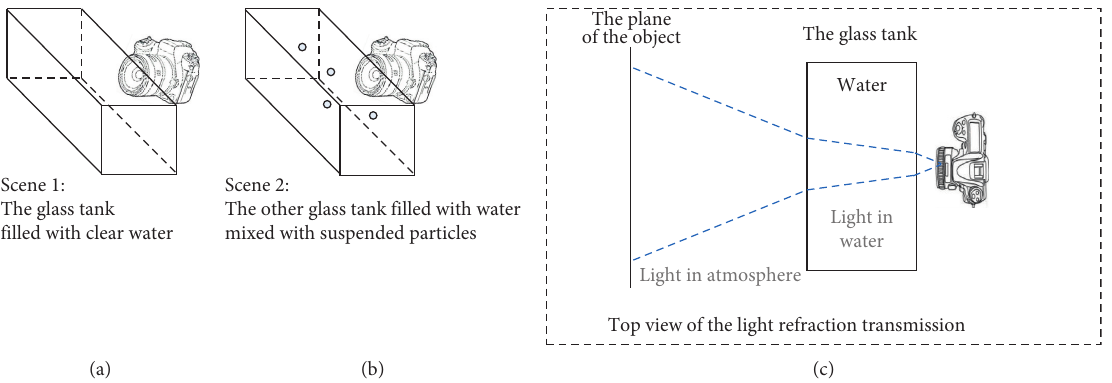
Figure 5: The experimental schematics of collecting images. The subimage in the upper-left corner shows the experimental equipment to collect the ground truth. The subimage in the upper-right corner shows the equipment to collect the underwater images to be restored. The bottom subimage surrounded by a dashed box represents a top view of the experimental equipment.